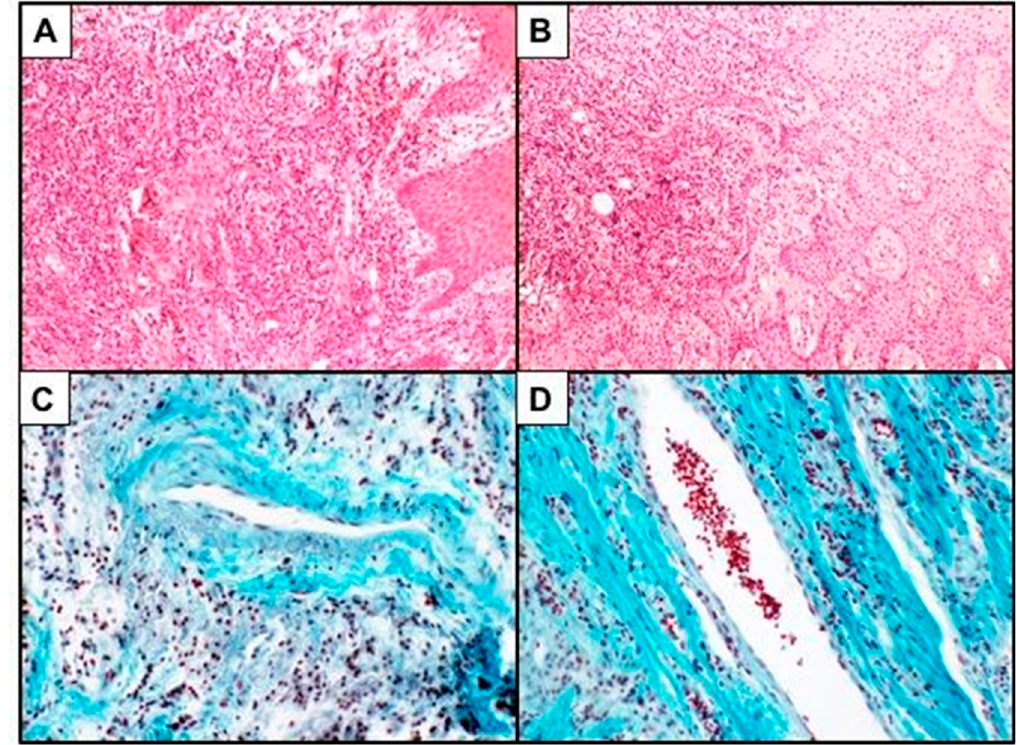
Figure 1. A–B: Hematoxylin and eosin staining (X100) showing inflammatory cells in the gingival mucosa; C–D: Masson–Goldner trichrome staining showing vessels in the gingival mucosa